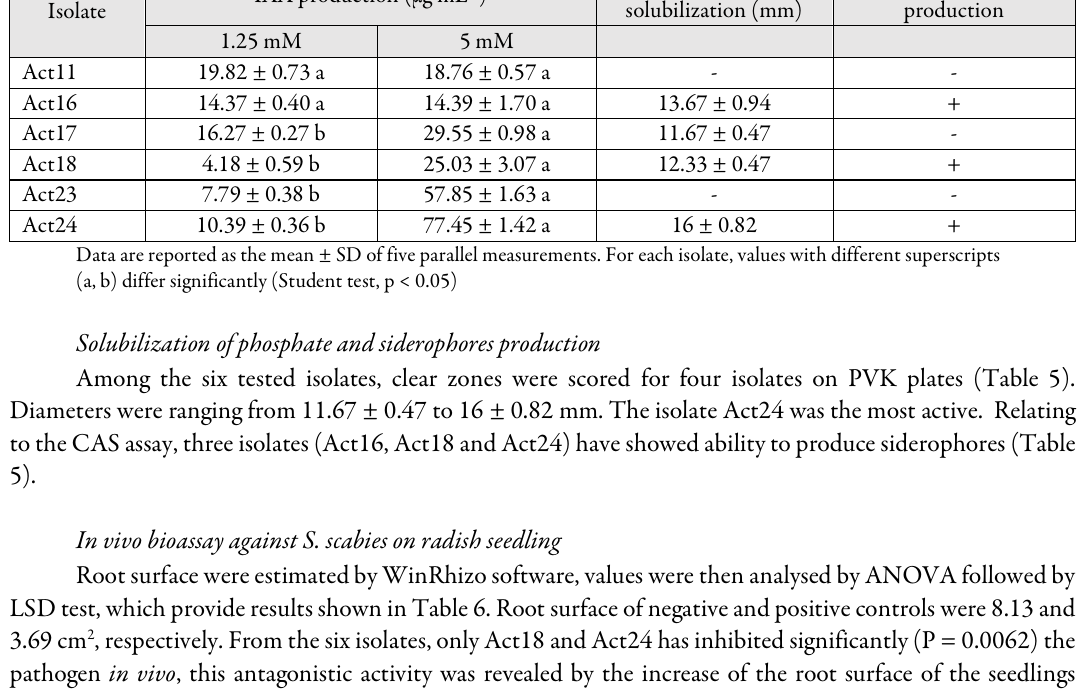
Siderophores production